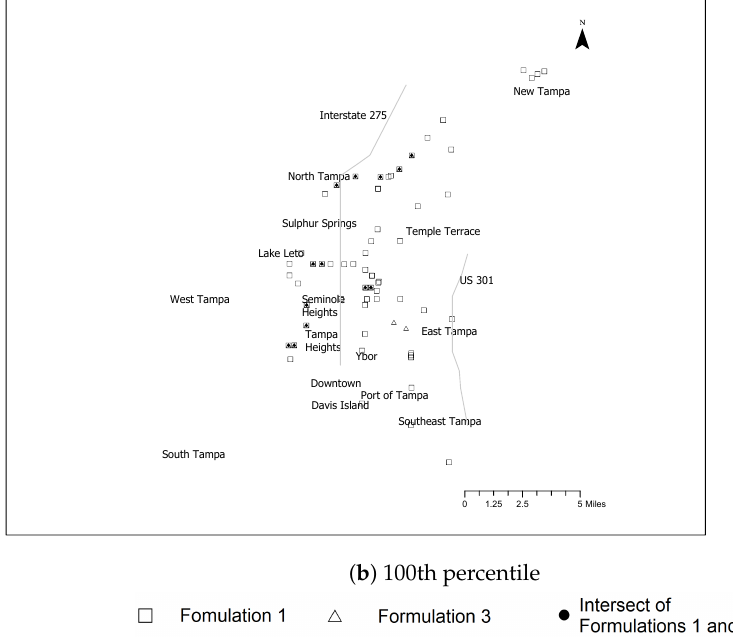
Figure 8. Maps of valves identified by formulations 1 and 3 at various percentiles for the frequency of occurrence in the solution